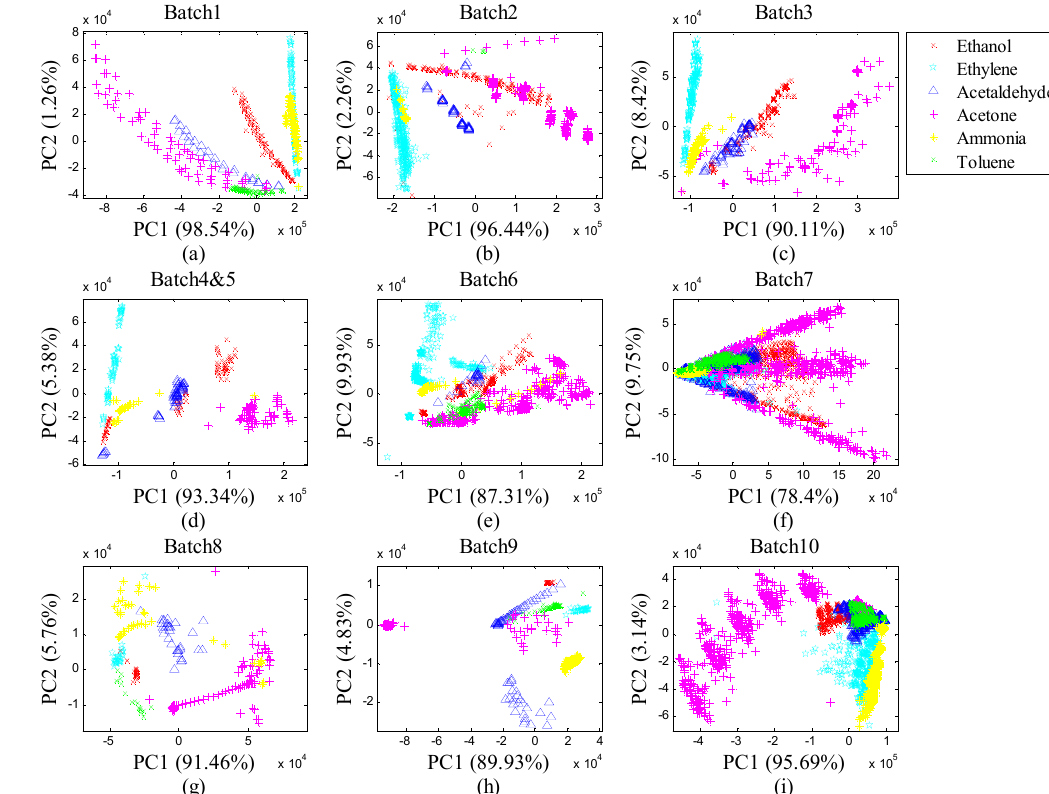
Figure 3. ( a ) Data distribution of Batch 1; ( b ) data distribution of Batch 2; ( c ) data distribution of Batch 3; ( d ) data distribution of Batch 4&5; ( e ) data distribution of Batch 6; ( f ) data distribution of Batch 7; ( g ) data distribution of Batch 8; ( h ) data distribution of Batch 9; ( i ) data distribution of Batch 10.